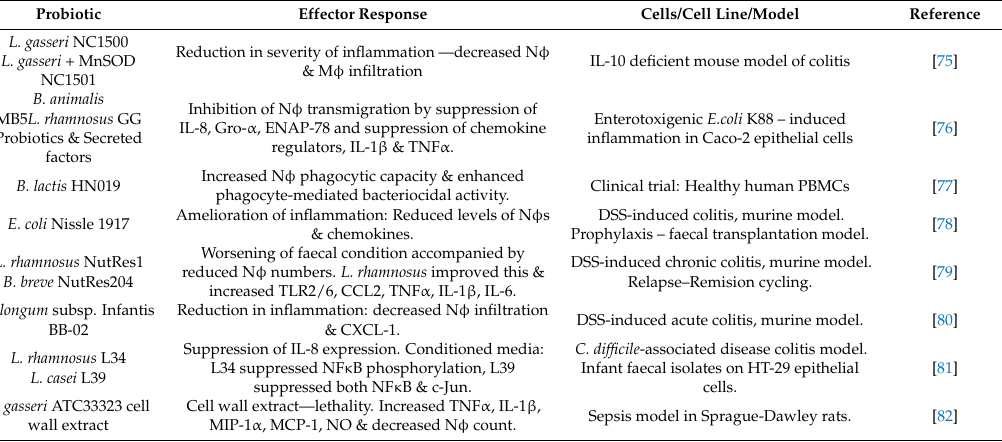
Table 3. Probiotic modulation of neutrophil effector function and signaling